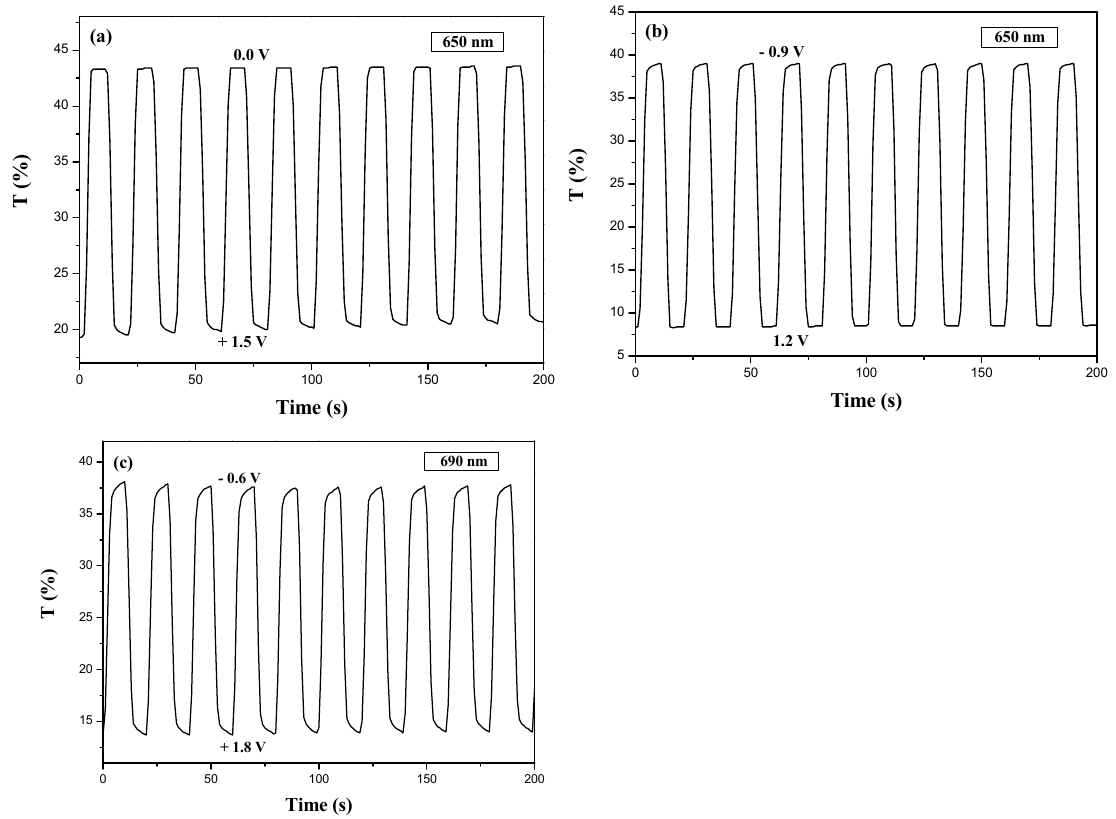
Figure 10. Transmittance variations of ( a ) PInc/PMMA-PC-ACN-LiClO 4 /PEDOT-PSS; ( b ) P(Inc- co -bT)/PMMA-PC-ACN-LiClO 4 /PEDOT-PSS; and ( c ) PbT/PMMA-PC-ACN-LiClO 4 /PEDOT-PSS ECDs with a residence time of 10 s. Table 3. Optical and electrochemical properties investigated at the selected applied wavelength for the devices.